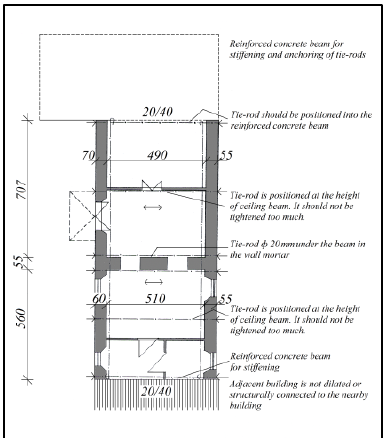
Figure 25. Cross-section—Positioning of tie-beams at each floor level.